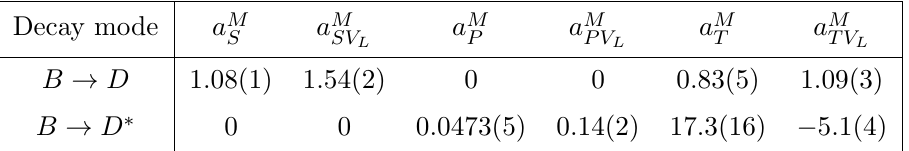
Table 2 . Numeric coe(cid:14)cients in eq. (3.9) for M = D; D (cid:3) obtained by using the hadronic parameters described in section 3.1, assuming that NP only modi(cid:12)es the coe(cid:14)cients g S transition b c(cid:28) (cid:22) (cid:23) , cf. eq. (3.7). ! where g (cid:28) = g (cid:28) g (cid:28) , and the numeric coe(cid:14)cients a D S R (cid:6) S L S ( P )